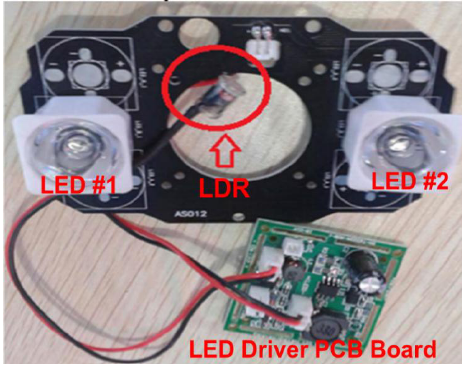
Figure 1. Demonstration board design implemented with the LDR, LED, and LED driver PCB.